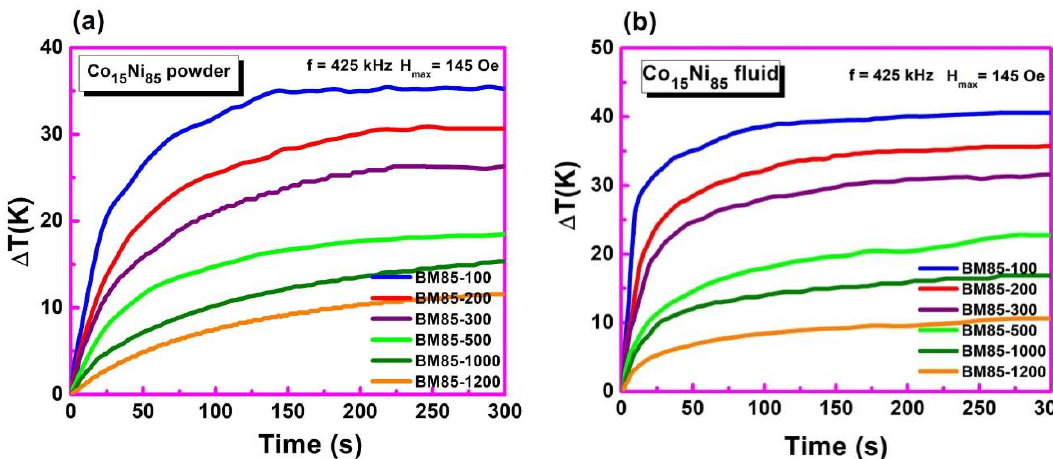
Figure 11. Heating curves of representative Co 15 Ni 85 NPs milled at 1425 rpm for 100, 200, 300, 500, 1000 and 1200 min. ( a ) 20 mg of powder and ( b ) 1000 µ L of the fluid sample measured in an AC magnetic field of amplitude H max = 145 Oe and frequency f = 425